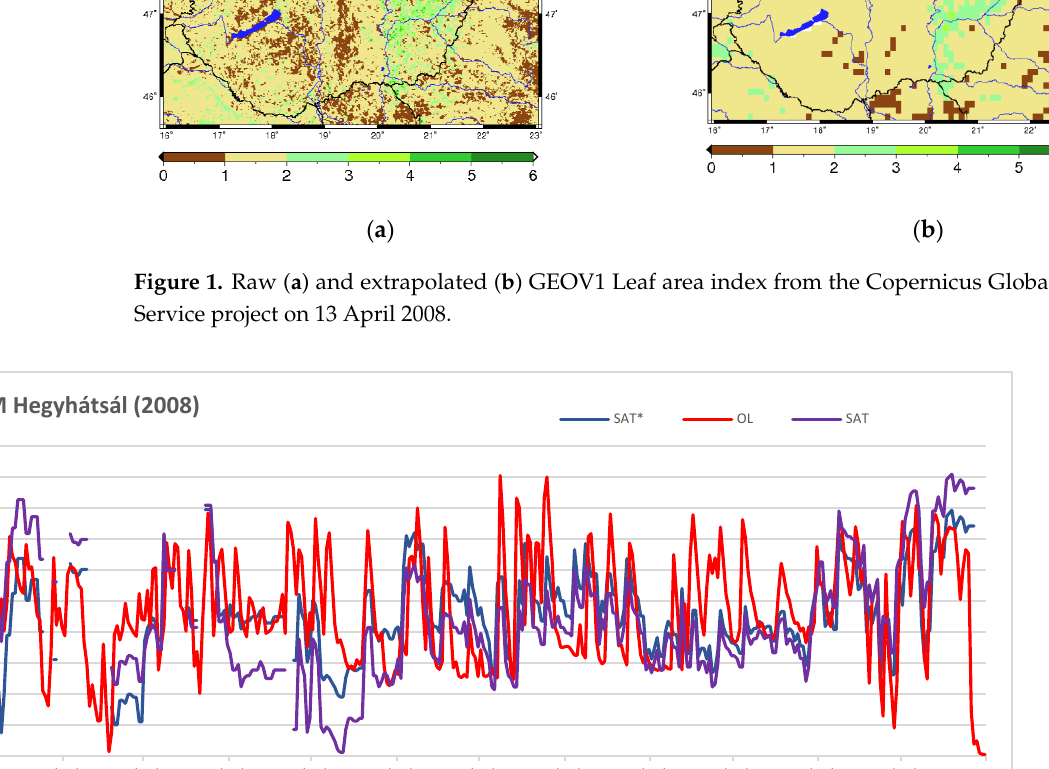
Figure 2. Surface soil moisture evolutions for 2008 at Hegyhátsál (West-Hungary) for model (red), raw ASCAT satellite observations (purple) and ASCAT seasonal CDF rescaled (blue) observations.